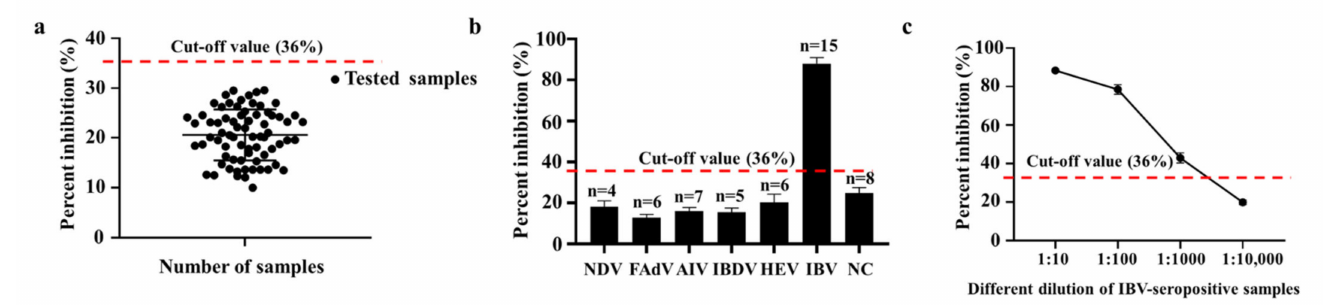
Figure 6. Specificity and sensitivity the cELISA for detecting anti-IBV antibodies. ( a ) 72 IBV- seronegative serum samples were tested using the cELISA for calculating the cut-off value. ( b ) As- sessment of the cELISA detecting the antibodies against other chicken disease viruses, including NDV ( n = 4), FAdV ( n = 6), AIV ( n = 7), IBDV ( n = 5) and HEV ( n = 6). ( c ) Determination of the largest dilution of positive chicken serum for anti-IBV antibodies by the developed cELISA.